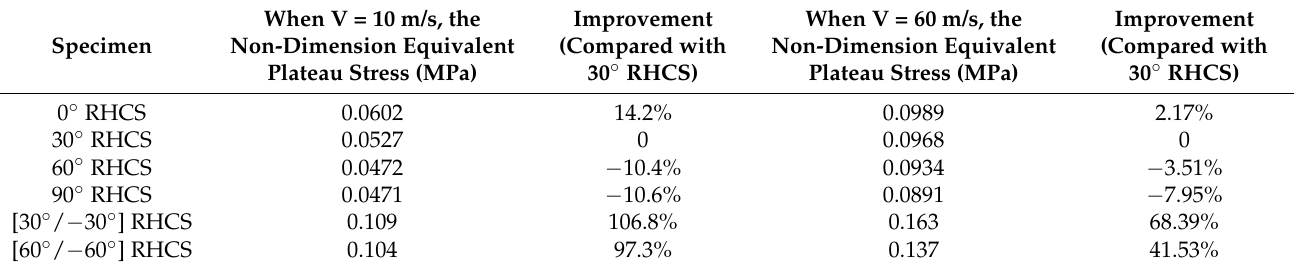
Table 2. The non-dimension equivalent plateau stress of